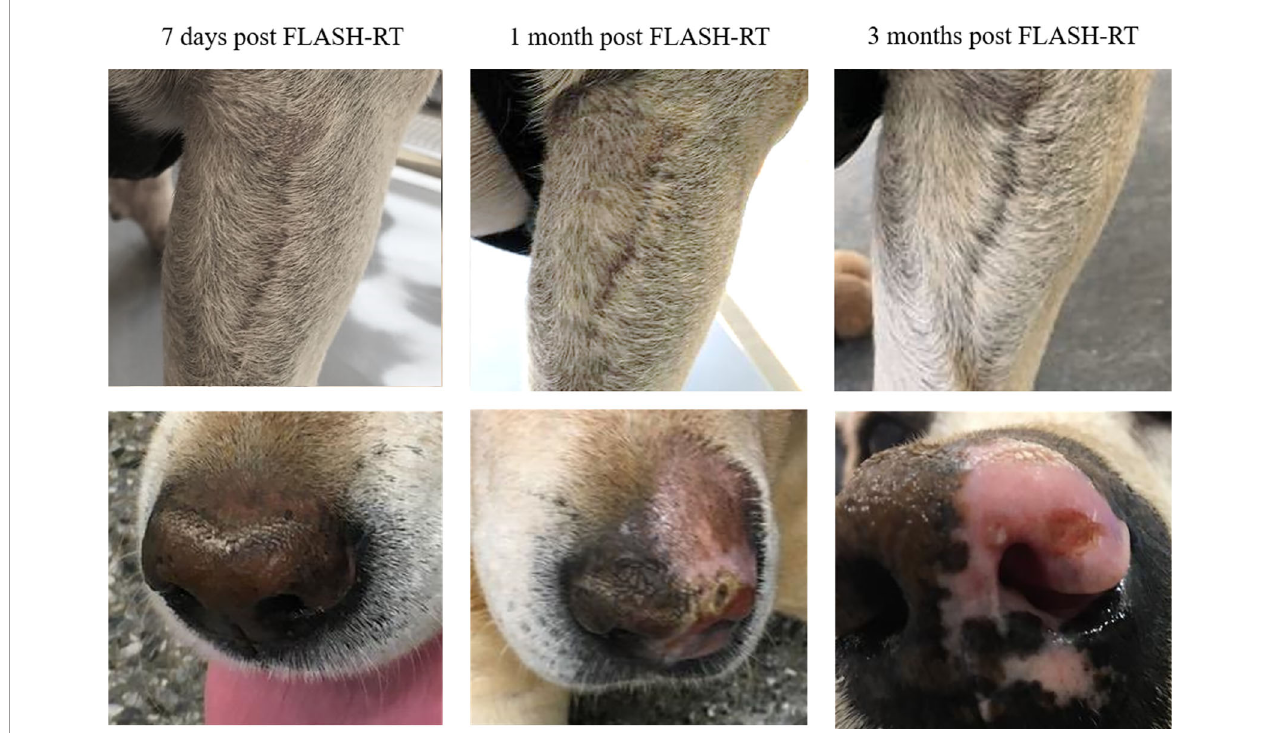
FIGURE 4 | Photographs of patient no. 1 with post-operative microscopic residual disease on the front limb (top row) and patient no. 10 with intranasal squamous cell carcinoma (bottom row) at 7 days, 1 month, and 3 months post FLASH-RT.